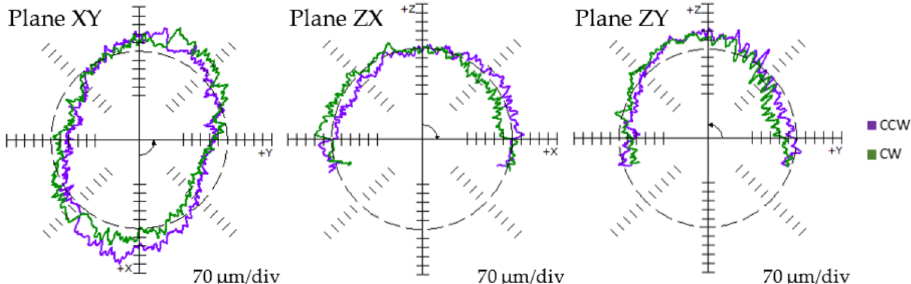
Figure 3. Polar graphs of the volumetric analysis evaluation—LR Mate 200iD.